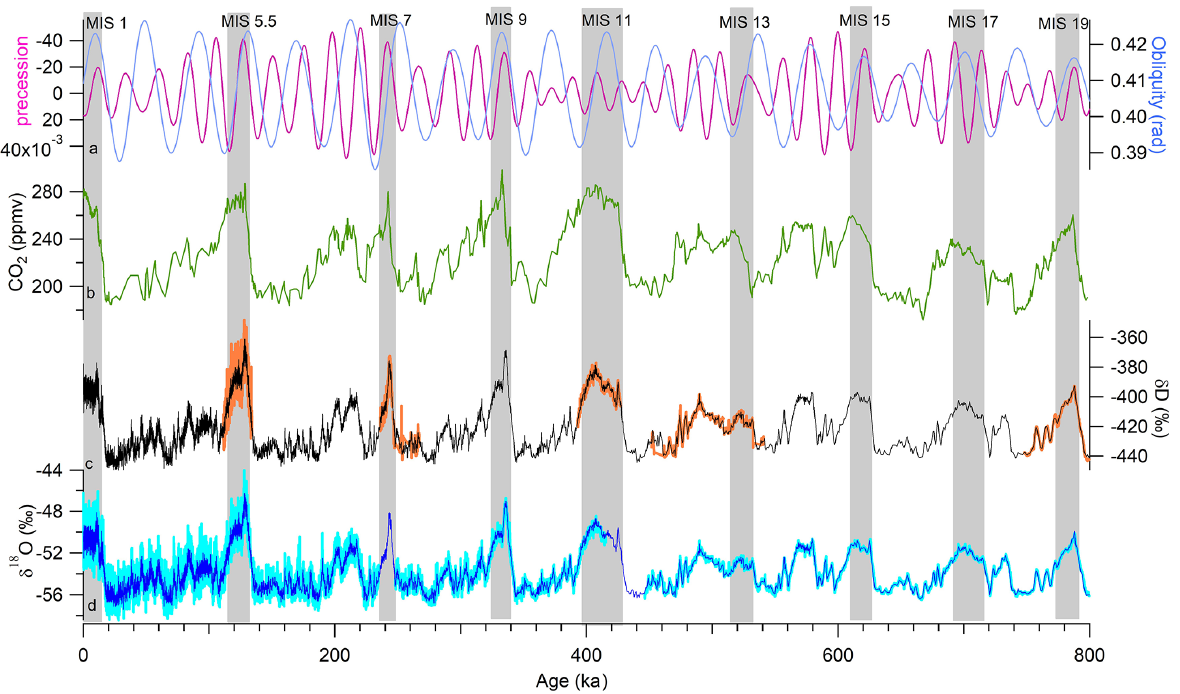
Figure 1. EDC ice core and other palaeoclimate records as well as variations in Milankovitch cycles over the past 800kyr. (a) Precession (pink) and obliquity (blue) from Laskar et al. (2004); (b) composite EDC and Vostok CO 2 record over the last 800kyr (Lüthi et al., 2008; Bereiter et al., 2015); (c) the EDC δ D record at 11cm (orange) and 55cm (black) resolution; and (d) the EDC δ 18 O record at 11cm (light blue) and 55cm (dark blue) resolution. All ice core records are presented on the AICC2012 scale (Bazin et al., 2013; Veres et al., 2013). Grey rectangles indicate the positions of interglacial periods. Table 3. Time resolutions (in years) of the different MRA decompositions for specific intervals (0–56, 56–144, 144–305, 305–420, 420–651 and 651–800ka). Letters a, b, c, d, e and f represent segments that have the same time resolution and can be combined. Interval Decomp. Interval